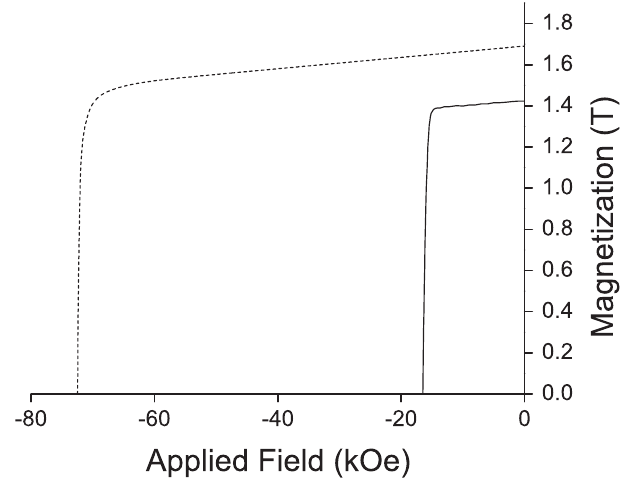
Þ Fe B mag- ; Pr 0 2 14 : 2 : 8